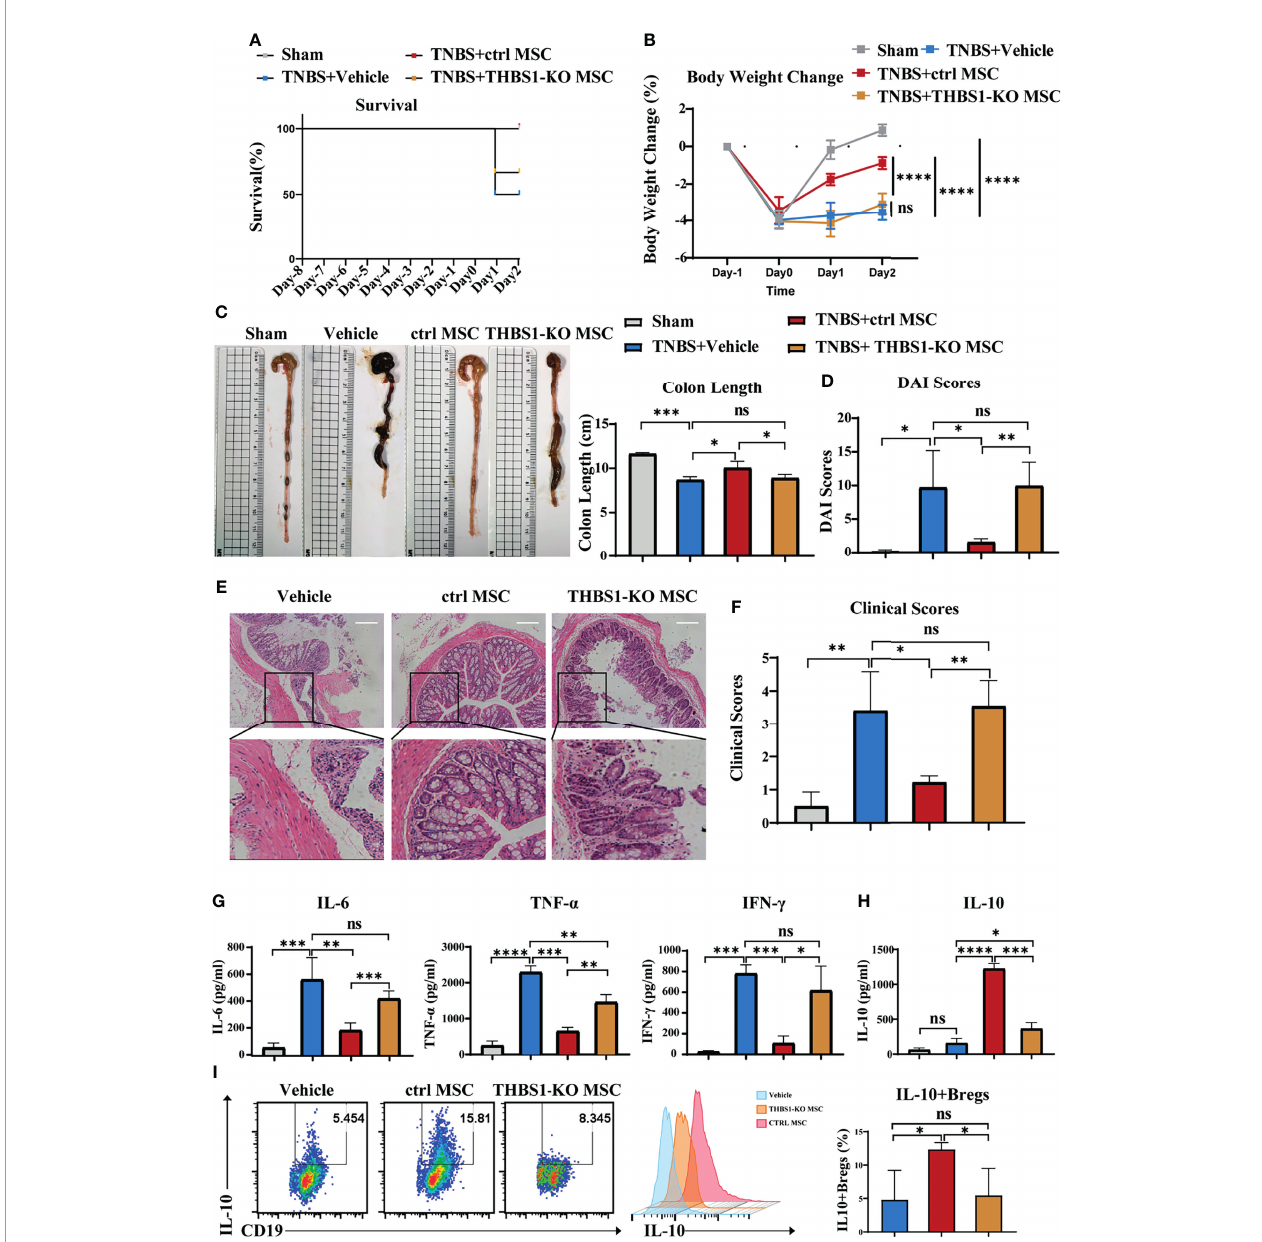
FIGURE 5 | THBS1 plays a vital role in MSCs inducing IL-10 + Bregs and protecting mice from colitis. THBS1-KO MSCs and control MSCs were separately injected into the peritoneal cavity of mice with colitis, and their therapeutic effects were evaluated. (A) Comparison of survival rate, (B) comparison of body weight loss, (C) representative colon graph and statistical colon length, (D) comparison of DAI scores. (E) Histological examination of colon cross sections via H&E staining and (F) histological scoring. (G) Colon tissue was collected, and the expression levels of proin fl ammatory cytokines in colon homogenate were detected by ELISA. (H) Peritoneal lavage fl uid (including peritoneal cells) was collected, and the peritoneal fl uid IL-10 level was determined by ELISA. (I) Peritoneal lavage fl uid (including peritoneal cells) was collected, and the frequency of peritoneal IL-10 + Bregs was detected via fl ow cytometry. Data are presented as the means ± SD, n ≥ 3.